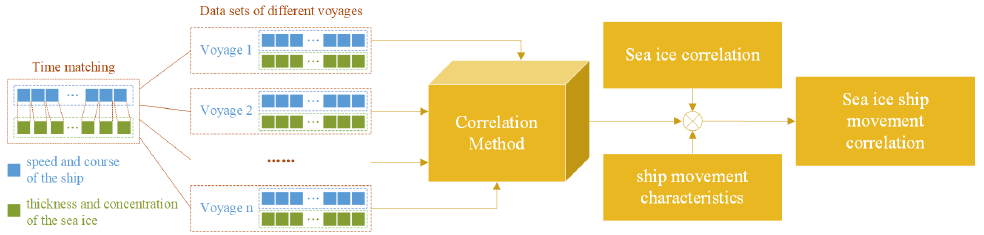
Figure 1. Framework for analysis of the correlation between ice conditions and ship movement char- acteristics.